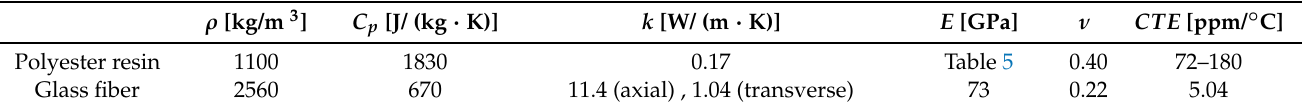
Table 4. Thermal and mechanical material properties of the glass fiber and resin system used in this study (reproduced from [7] with the